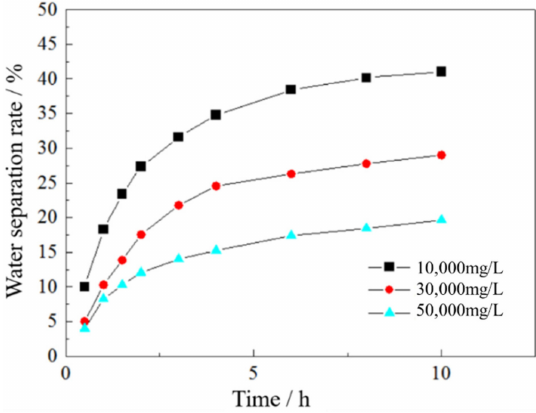
Figure 11. Change of the water release rate with di ff erent salinity